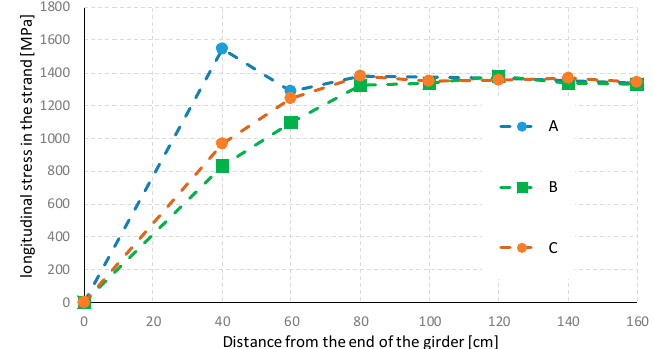
Figure 16. Longitudinal stresses in three measured strands.